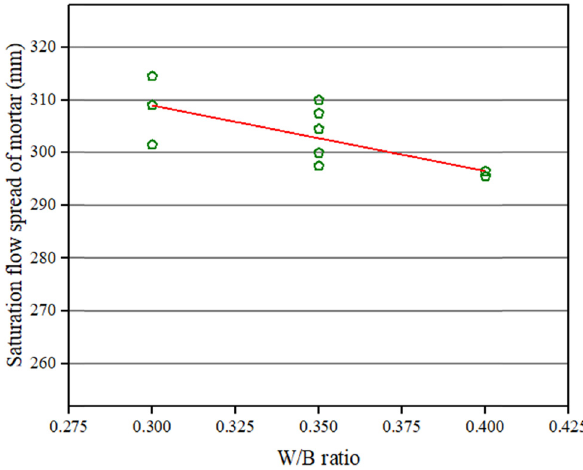
Figure 2: E ff ect of W/B ratio on the fl ow spread of mortars [ 44